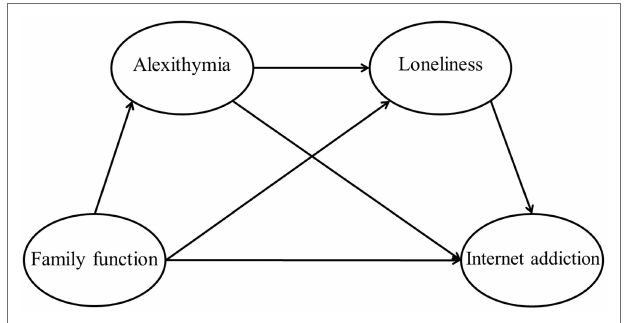
FIGURE 1 | The proposed